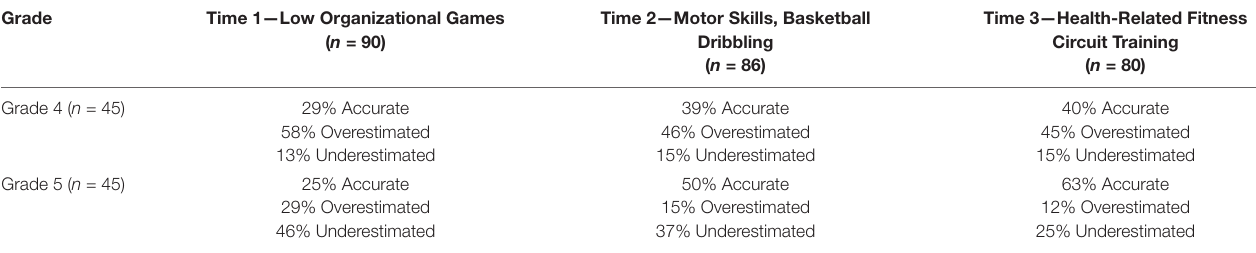
TABLE 1 | Objectively measured physical activity versus student reported physical activity. Grade Time 1—Low Organizational Games ( n =